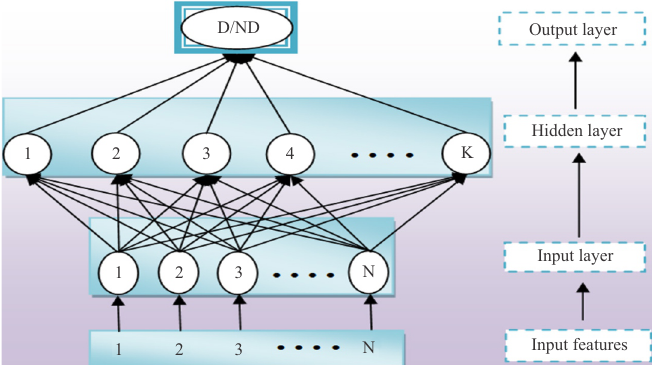
Fig. 1. Illustration of feed – forward MLP neural network